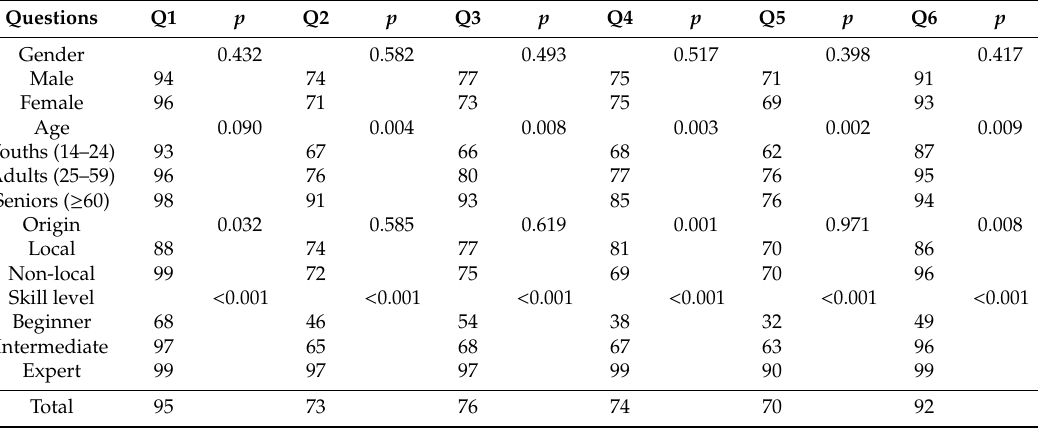
Table 8. Passive knowledge of existing rules